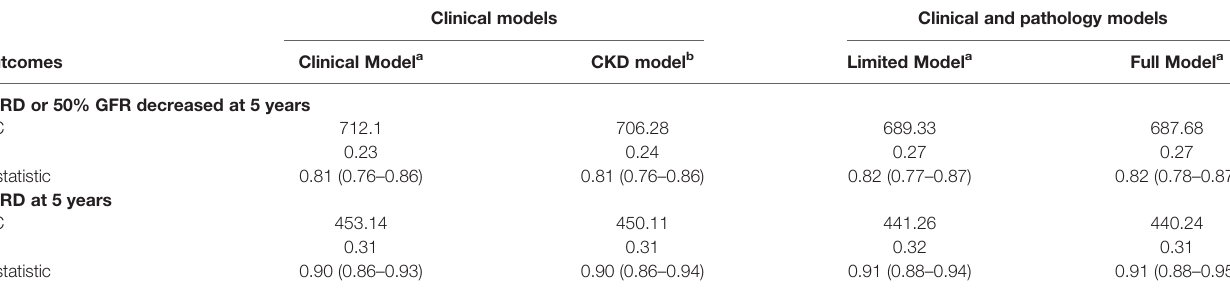
TABLE 2 | The goodness of fi t for different models predicting the composite outcome (50% GFR declined or ESRD) and ESRD at 5